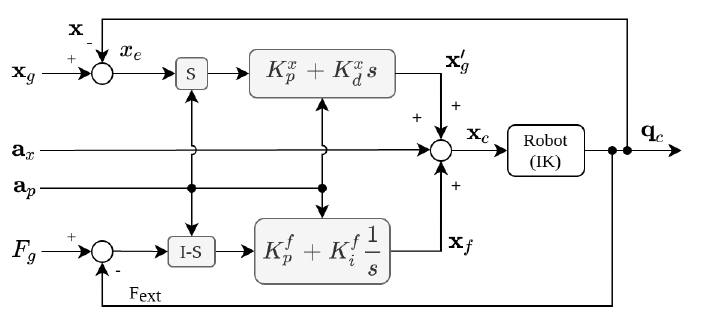
Figure 4. Adaptive parallel position-force control scheme [24]. Inputs are the estimated goal position, policy actions, and a desired contact force. Controller outputs the joint position commands for the robotic